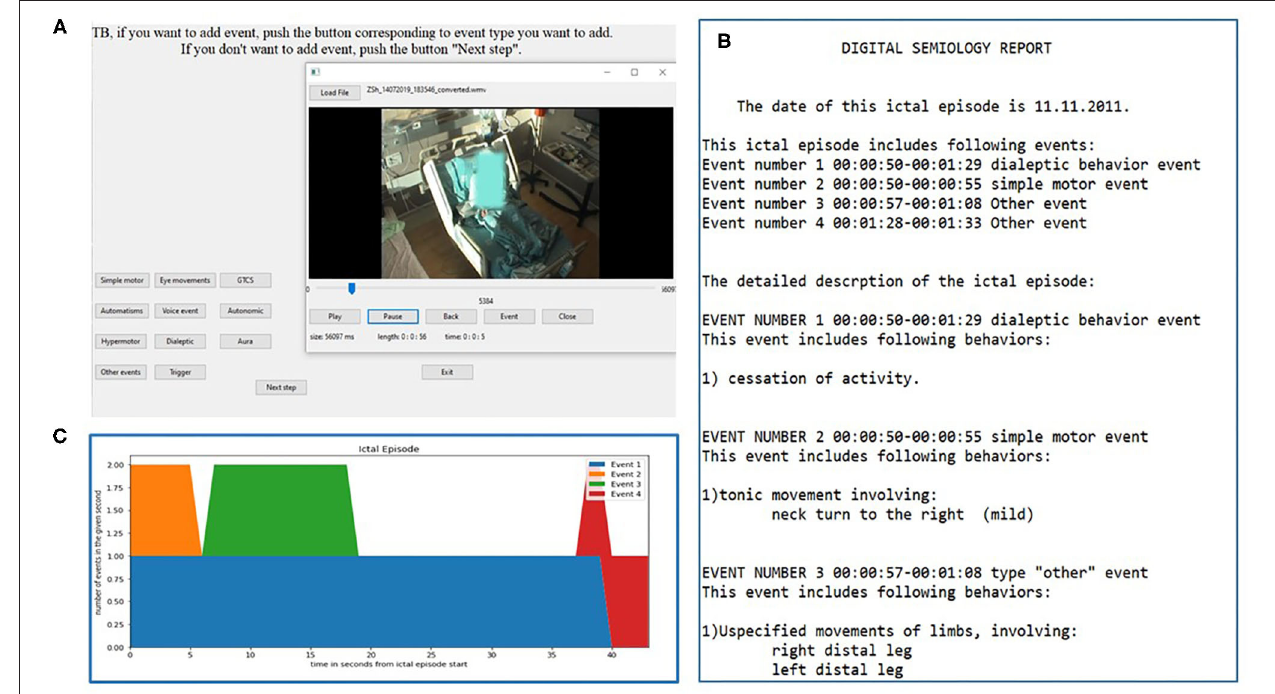
FIGURE 1 | Digital semiology interface and report. The interactive window for video annotation is shown in (A) . The encoder can move back and forth within the video and the timing selected is automatically inserted into the report. The example shows the “event type” selection window. An example of the final report and its graphic representation are seen in (B,C) ,